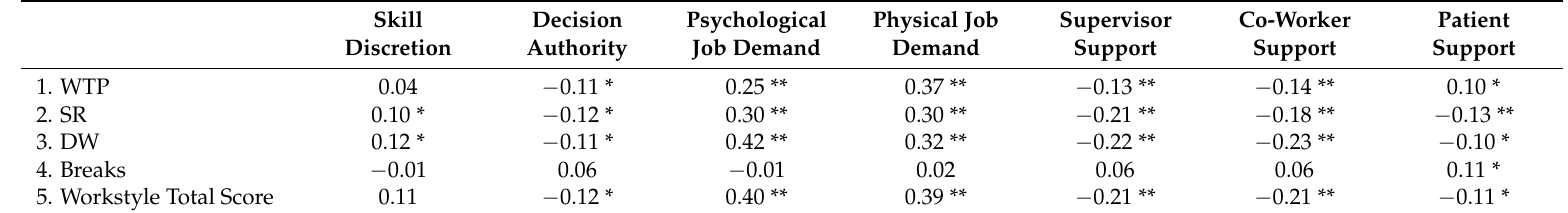
Table 5. Correlations between C-WSF-24 and Job Content Questionnaire (JCQ) subscales by non-parametric Spearman’s